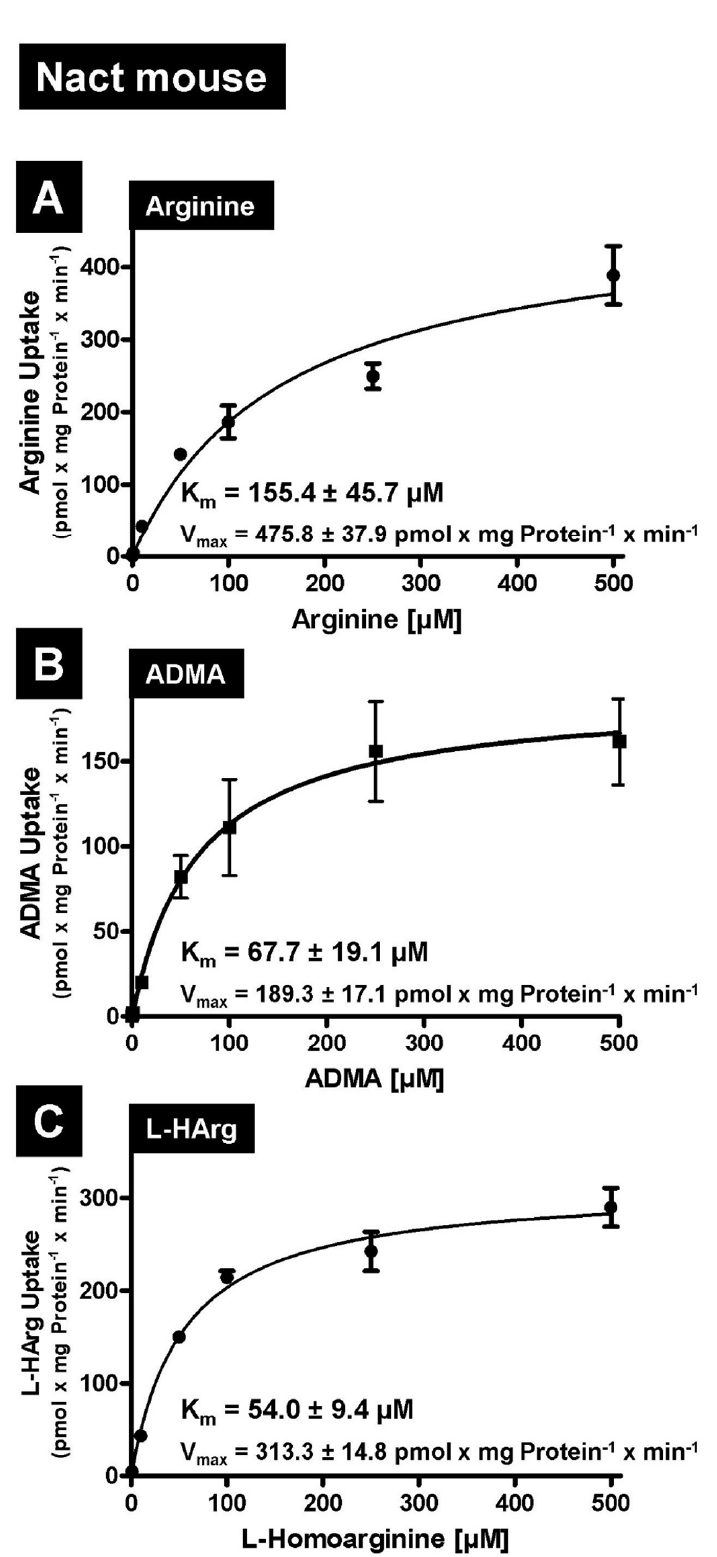
Figure 3. Determination of the kinetic transport constants (K m values) and of the transport velocities (V max values) of mouse Nact-mediated Arginine ( A ), ADMA ( B ) and L-homoarginine ( C ) uptake. Uptake is based on net uptake values by subtracting the uptake into HEK-Co control cells from the uptake into HEK-Nact cells.